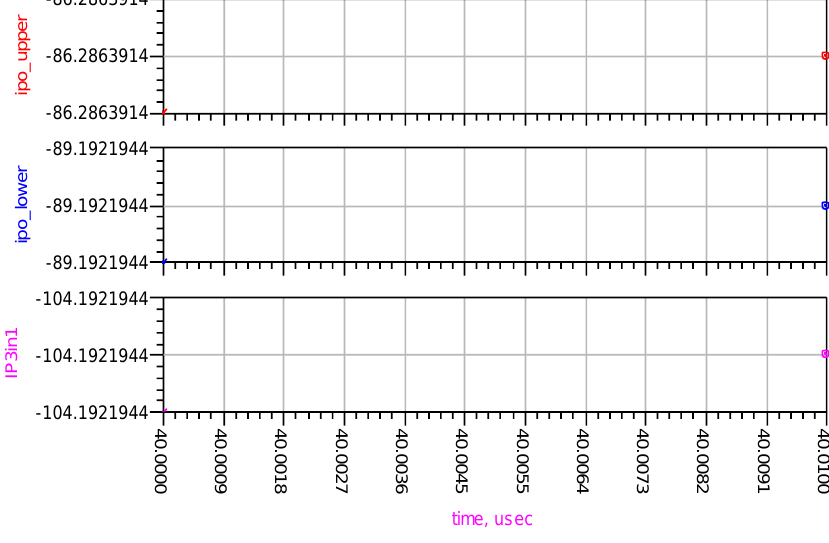
Figure 14. Chart and IP3